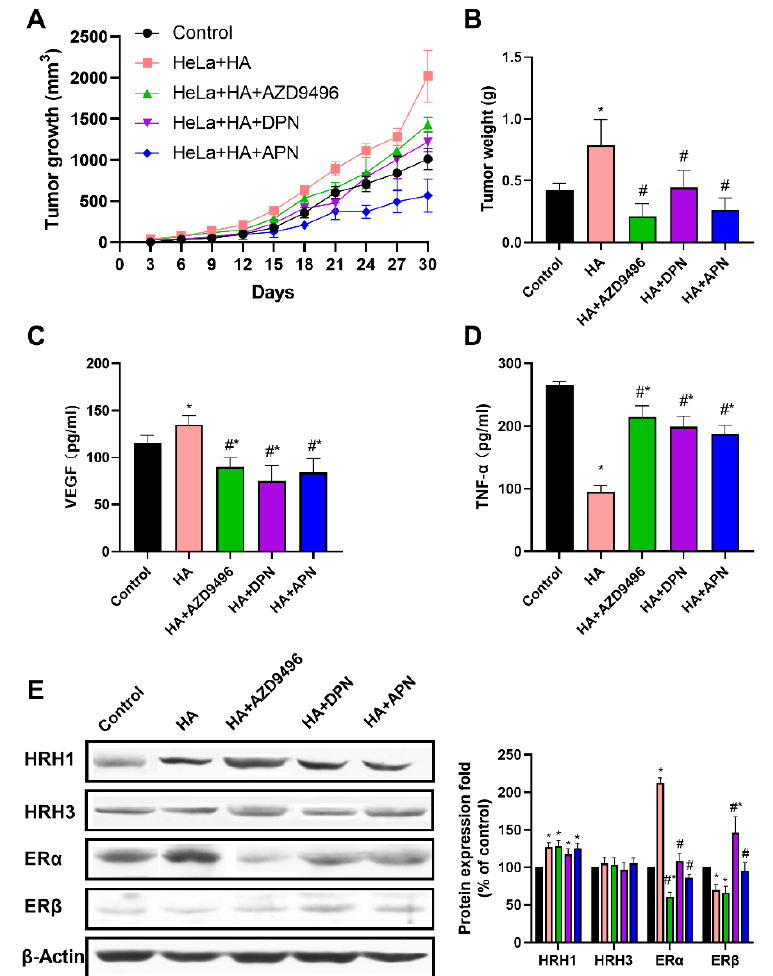
Figure 5. Apigenin inhibited cervical tumor growth in vivo by attenuating the abnormal ER signaling caused by histamine. HeLa cells were injected subcutaneously into the lower right side of female BALB/c nude mice. After 6 days, mice were divided into five groups; control, HeLa + HA (1 mg/kg), HA + AZD9496 (1 mg/kg + 2 mg/kg), HA + DPN (1 mg/kg + 2 mg/kg) and HA + APN (1 mg/kg + 100 mg/kg). Animals were intraperitoneally injected with these reagents every 3 days. Effects of apigenin on cervical tumor growth was determined by the tumor volume and tumor weight. ( A ) Average tumor volume was measured every 3 days. ( B ) Tumor weights were measured at the end of treatment. ( C ) ELISA analysis for serum VEGF levels. ( D ) ELISA analysis for serum TNF-α levels. ( E ) Western blot analysis on the expression level of ERα, ERβ, HRH1 and HRH3 from respective tumor tissues. The antibodies used in this experiment were ERα (ab32063), ERβ (ab288), HRH1 (ABP51517) and HRH3 (ABP53626). The results are expressed as a percentage of control, which is set at 100%. The serum used in ( C ) and ( D ) was obtained from the orbital sinus of mice. Data are presented as the mean ± SEM of at least three independent experiments. * p < 0.05 versus the control group, # p < 0.05 versus the HA group.